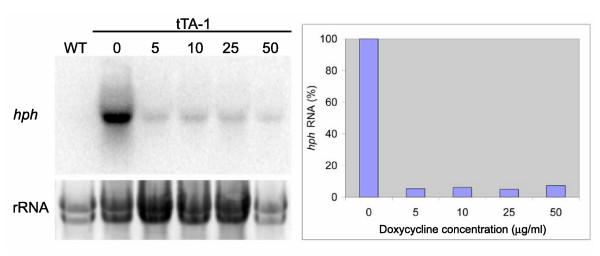
Doxycycline-regulation is enhanced in low-iron medium. Total RNA was isolated from an overnight culture of the tTA-1 transformant (Fig. 4) growing in Aspergillus minimal medium supplemented with one tenth the normal concentration of iron and the indicated concentrations of doxycycline (0–50 μg/ml). RNA was fractionated by agarose gel electrophoresis, transferred to nylon membranes, and probed with a 32P-labeled hph probe. Wild type A. fumigatus is included in the first lane as a negative hybridization control. Hybridization intensity was normalized to levels of SYBR-green II-stained rRNA by phosphorimager analysis and is presented in the graph as a percentage of the signal obtained in the tTA-1 strain in the absence of doxycycline (0).